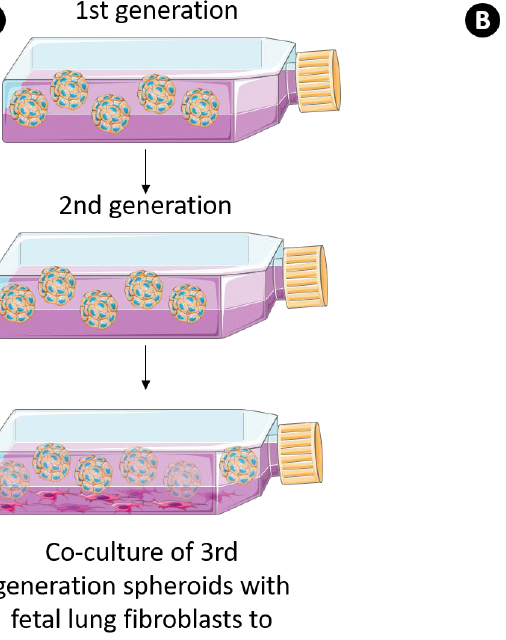
Figure 7. Inoculation of co-culture of spheroids and fetal lung fibroblasts into the mammary fat pad of nude rats. ( A ) 3rd generation breast cancer cell spheroids admixed with fetal lung fibroblast cells to mimic the stromal environment. ( B ) 3rd generation spheroids co-cultured with FLF were orthotopically transplanted into the mammary fat pad of nude rats. Abbreviations: FLF , fetal lung fibroblast; SP, spheroid.